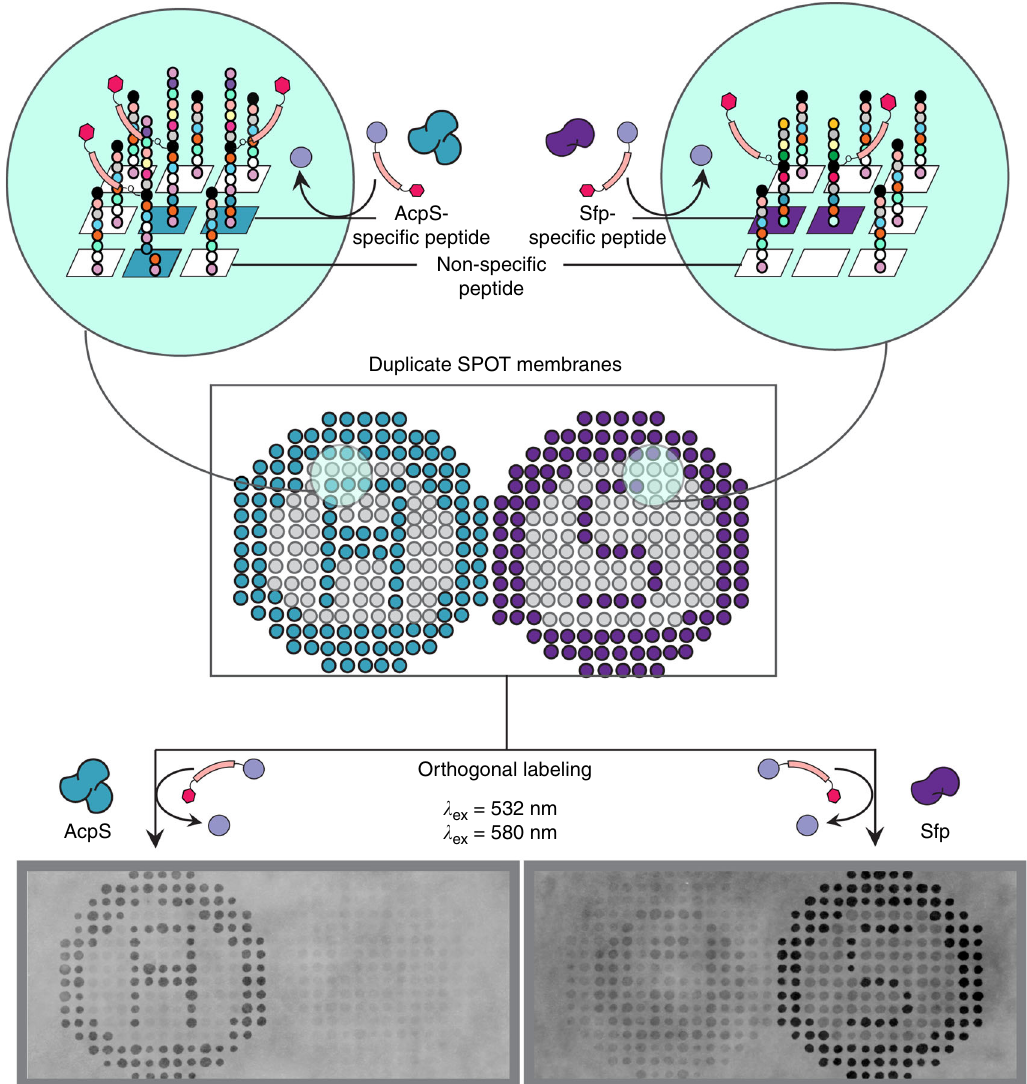
Fig. 6 Scheme illustrating selective Sfp and AcpS labeling on duplicate SPOT membranes. Peptide AVKMESLEYLDTM (4F01), speci fi c to Sfp, was synthesized on the cellulose membrane to highlight “ S, ” while peptide WPEEGIESFMSVPPP (4T25), speci fi c to AcpS, highlighting “ A. ” All un fi lled areas inside the circle were synthesized with a non-speci fi c peptide, IHDGADSVVWLWSNC, which was neither a substrate for Sfp nor